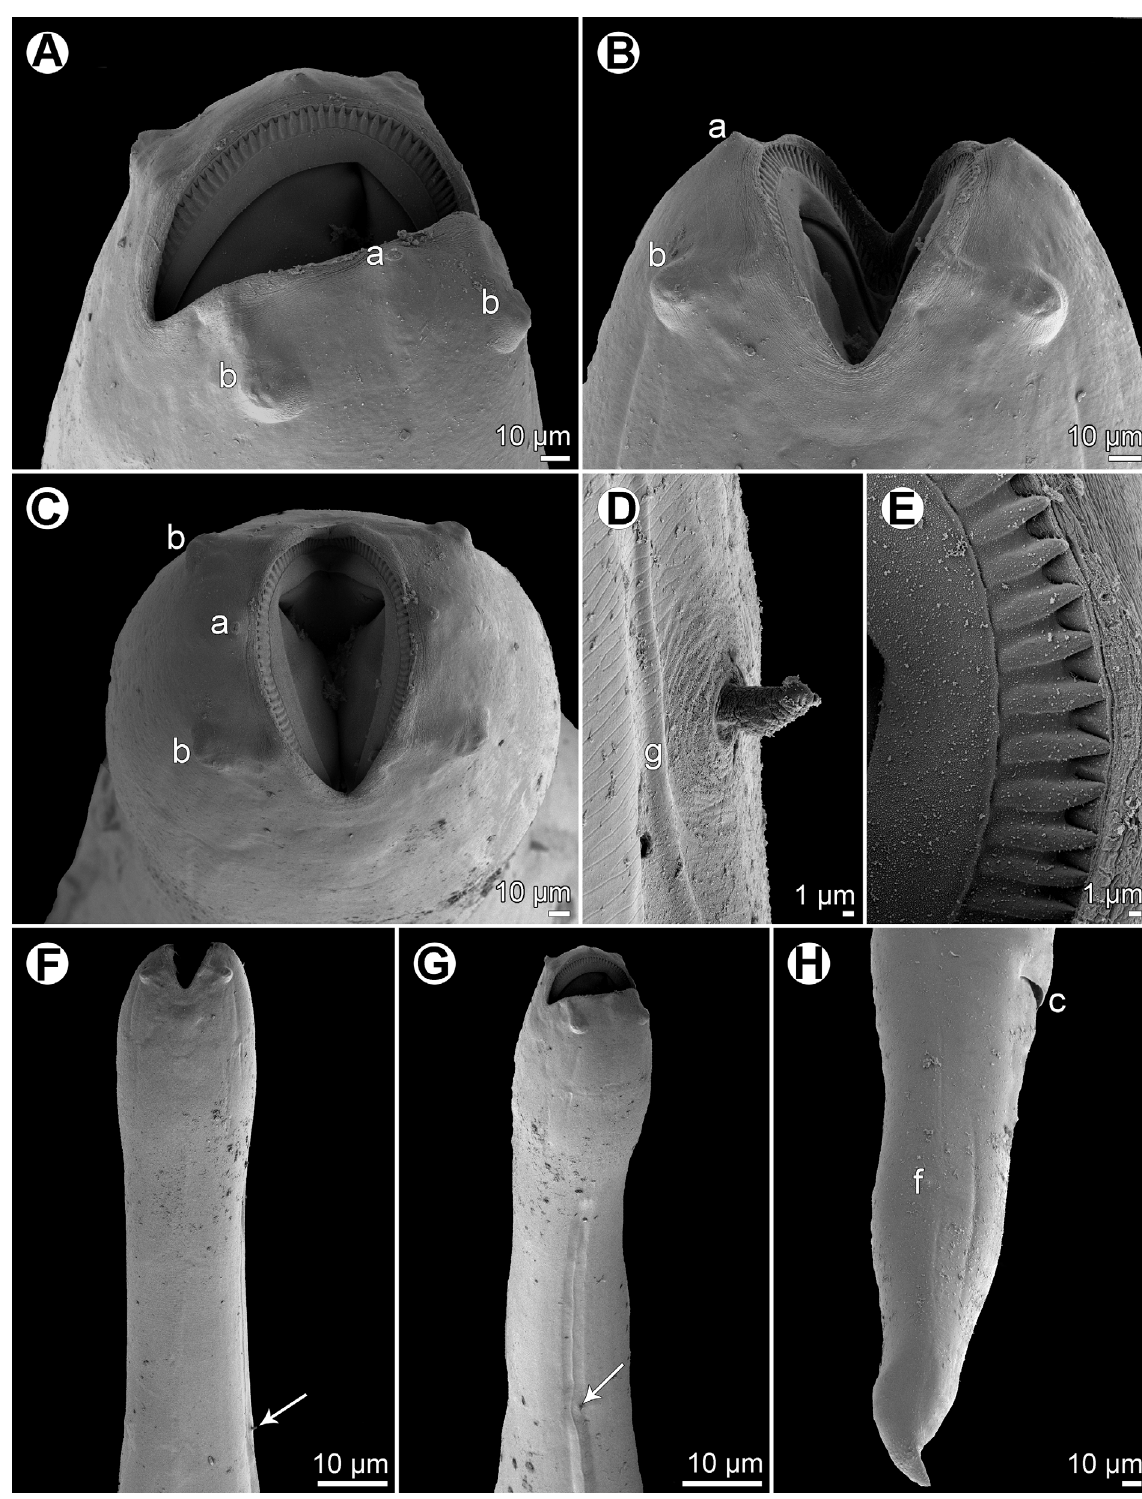
Figure 8. Cucullanus incognitus n. sp., scanning electron micrographs of female. (A, B) Cephalic end, sublateral and dorsoventral views, respectively; (C) same, apical view; (D) deirid and cervical ala, sublateral view; (E) cephalic teeth; (F, G) anterior end of body, dorsoventral and sublateral views, respectively (arrows indicate deirids; note cervical alae); (H) tail, lateral view. (a) amphid; (b) cephalic double papilla; (c) anus; (f) phasmid; (g) cervical